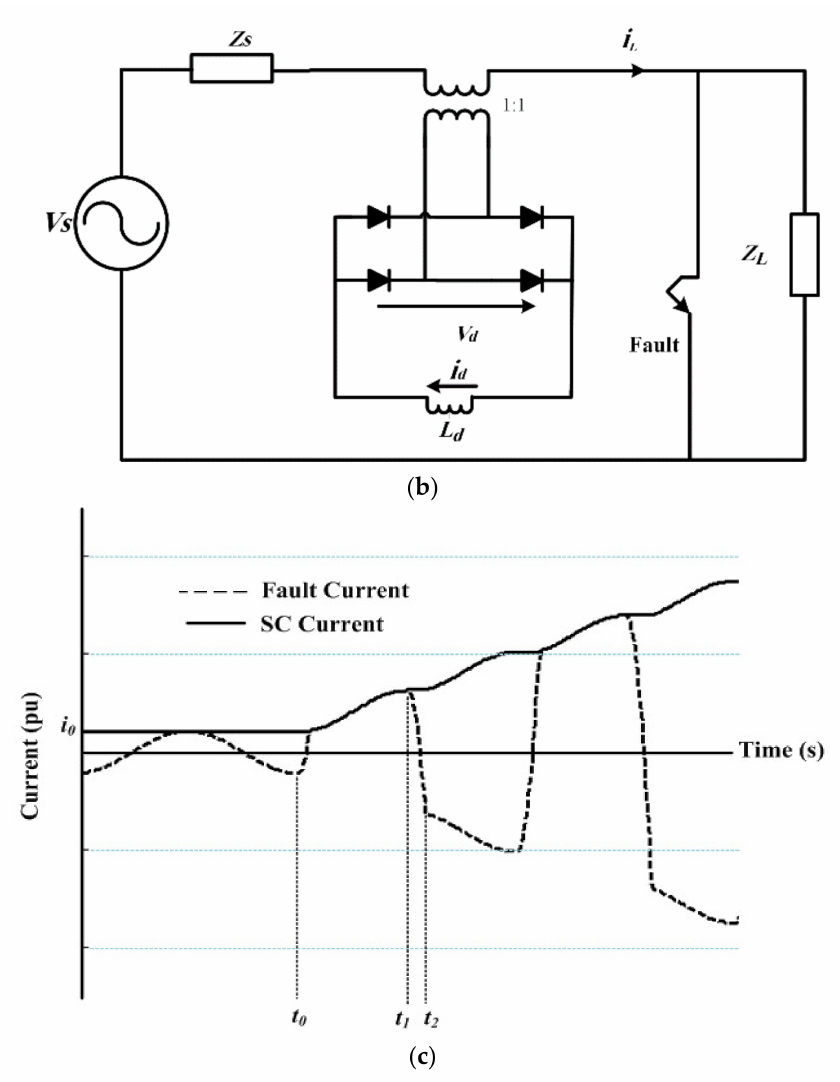
Figure 2. ( a ) BSFCL circuit; ( b ) test system for analytical analysis; ( c ) SC and fault current. Therefore, the BSFCL does not affect the line side under this condition. Once, a short circuit fault happens at t = t 0 , the SC current ( i d ) and subsequently the line fault current ( i L ) starts to increase with a constant rate. The performance of the BSFCL is divided into two periods. In the first period t 0 < t < t 1 , both SC and line currents are equal. The KVL law to obtain the line current ( i L ) is given by: